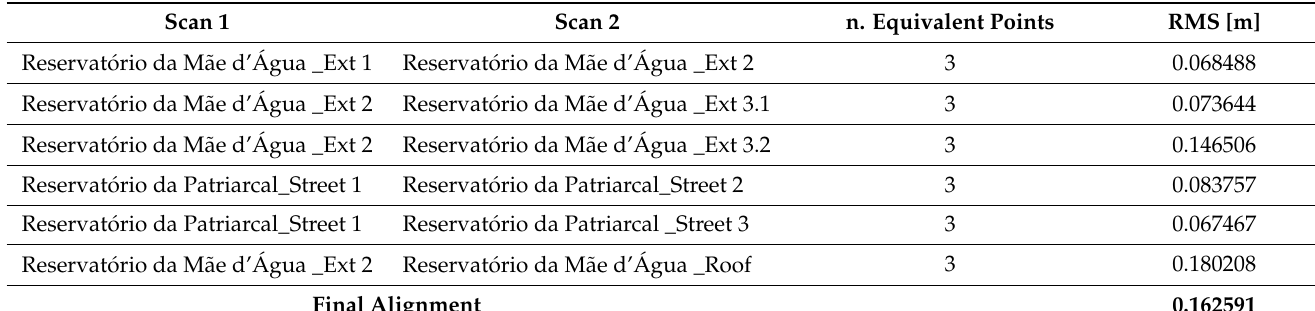
Table 4. Accuracy of point clouds